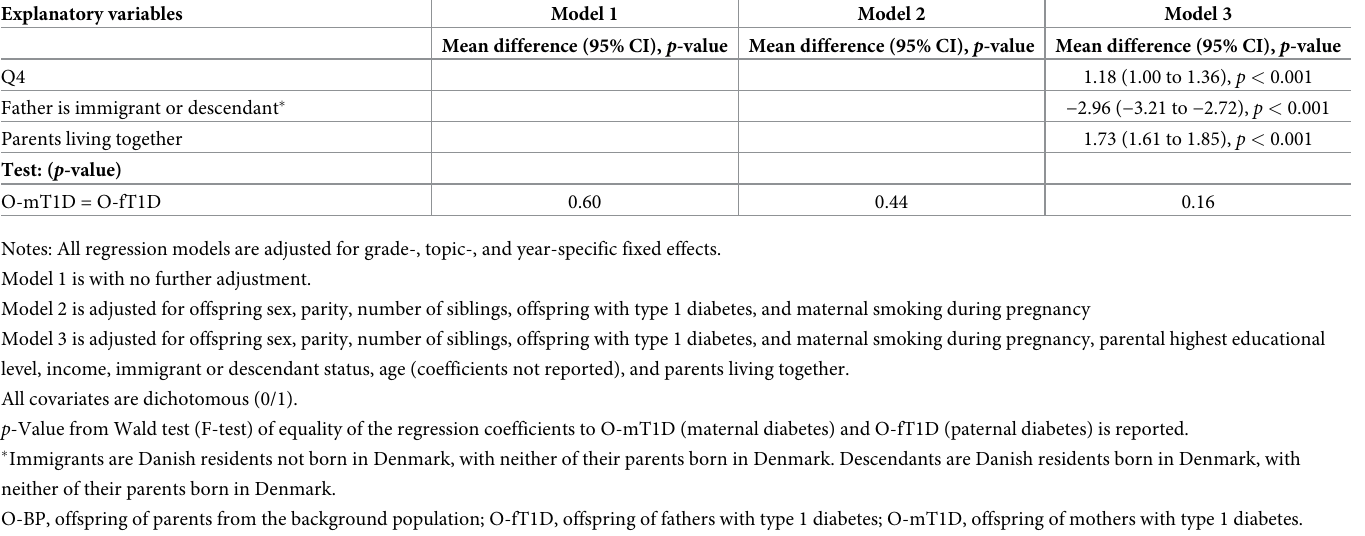
O-mT1D were found to have a lower overall reading test score (mean difference − 1.10 [95% CI − 2.05 to − 0.14, p = 0.02]) and lower reading test scores in fourth grade than O-BP (mean difference − 2.19 [95% CI − 3.58 to − 0.80, p = 0.002]) (Fig 1). Neither math test scores nor reading test scores differed for O-mT1D versus O-fT1D except for the overall math test score, which were lower for O-mT1D ( p = 0.0496) (Fig